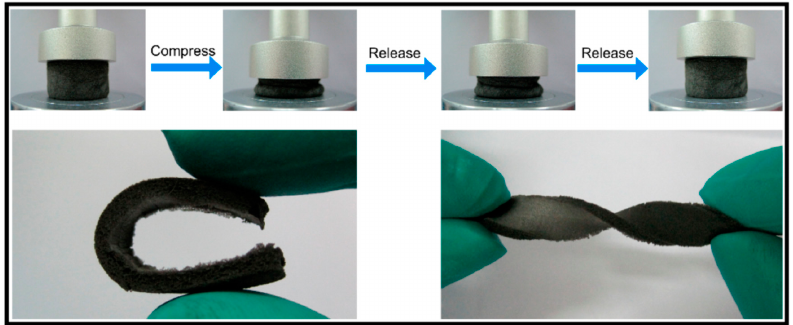
Figure 10. Images showing the recovery process of a compressed reduced graphene foam/polyimide composite and the high levels of bend and torsion deformations. Reproduced with permission from ref. [146].